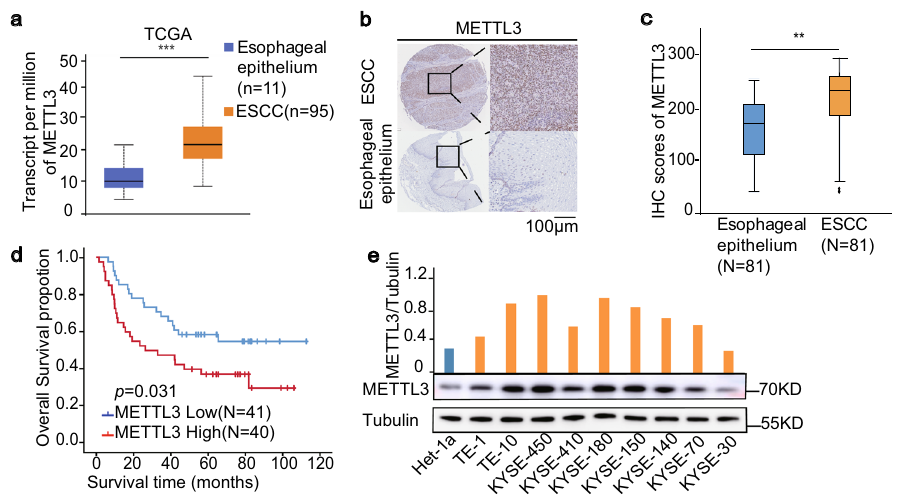
Fig. 1 Upregulated METTL3 is correlated with poor survival in ESCC patients. a The expression levels (transcript per million) of METTL3 were analysed in ESCC tissues ( n = 95) and their adjacent normal tissues ( n = 11) in the TCGA cohort. Data represent the means ± SD of samples. *** p = 2.21E − 07 based on two-tailed Student ’ s t -test. The box boundaries correspond to fi rst and third quartiles; whiskers extend to a maximum of 1.5× the interquartile range. b Representative images of IHC staining for METTL3 protein on a tissue microarray (TMA) composed of 81 ESCC tissues and their adjacent normal epithelium tissues. scale bars: 100 μ m. c The protein expression level of METTL3 were analysed in 81 ESCC tissues and their paired normal epithelium tissues by IHC. ** p = 0.0013. Two-tailed t -test in paired samples. The box boundaries correspond to the fi rst and third quartiles; whiskers extend to a maximum of 1.5× the interquartile range. d Kaplan – Meier method with two-tailed log-rank test was used to plot survival curves in human ESCC specimens ( n = 81) with high and low METTL3 expression. The log-rank test was used to compare survival rate. e Immunoblotting analyses of nine ESCC cell lines and Het-1-immortalized normal cells were performed with the indicated antibodies. METTL3 expression levels were quanti fi ed and normalized to tubulin expression levels. Source data are provided as a Source Data fi